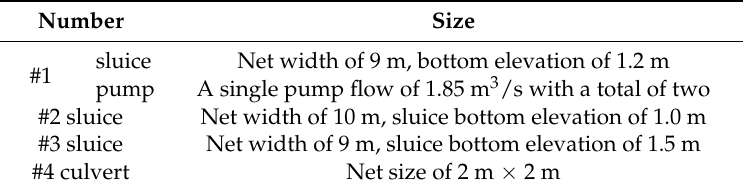
Table 3. Specification parameters of “three sluices and one